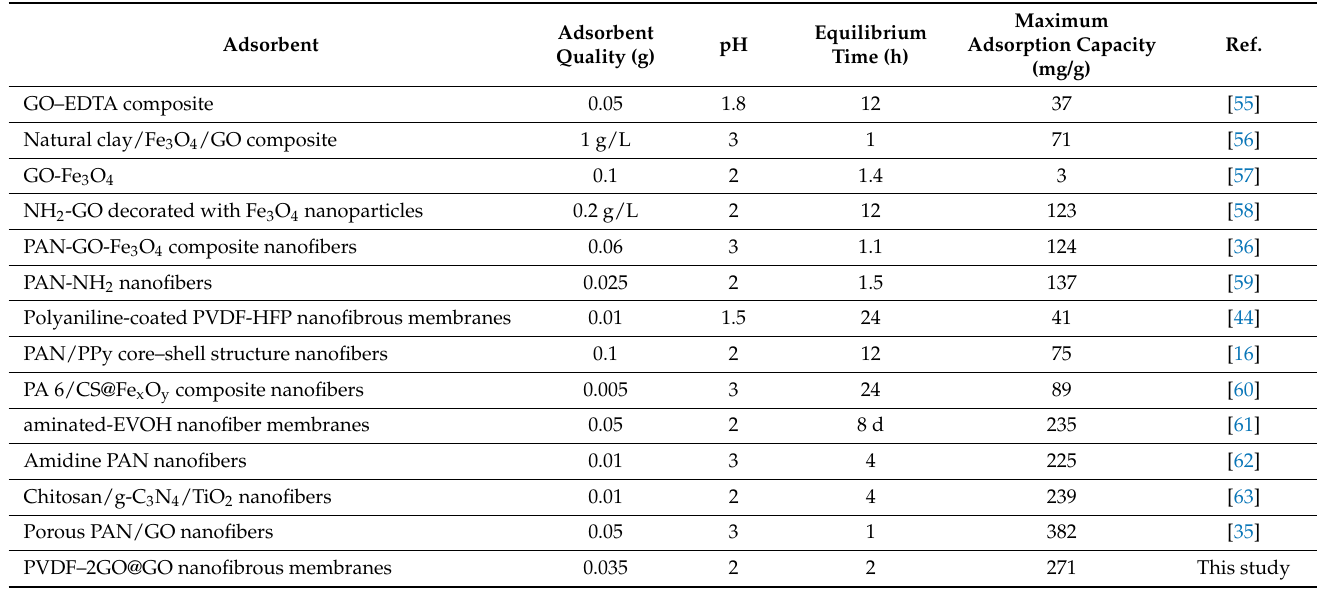
Table 3. Comparison of adsorption performance of the PVDF–2GO@GO nanofibrous membranes with other adsorbents for